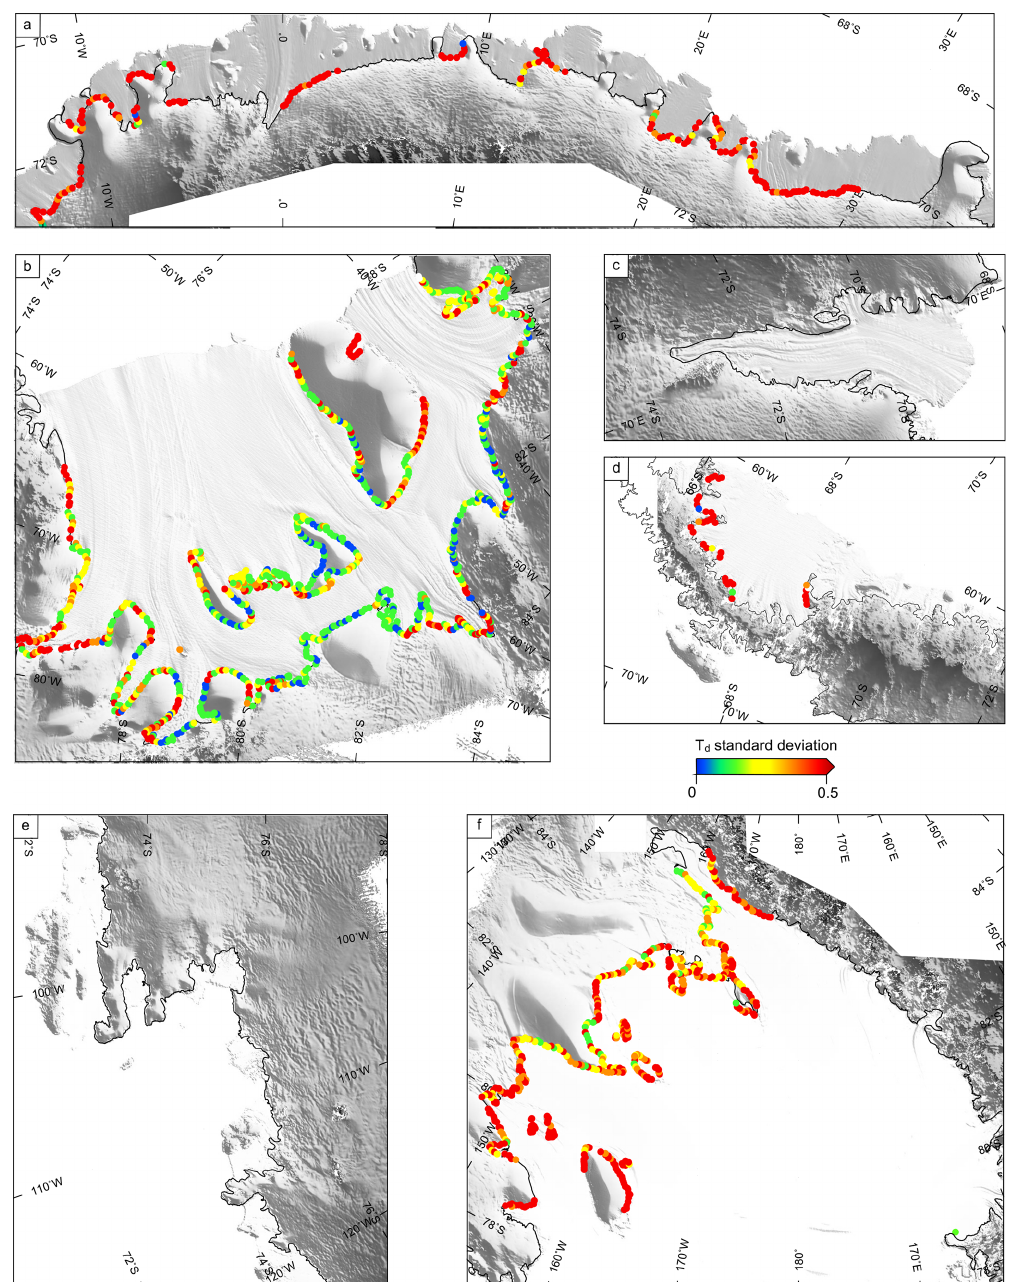
Figure A4. The standard deviation of T d for the mapped grounding zone for (a) Dronning Maud Land, (b) Filchner–Ronne Ice Shelf, (c) Amery Ice Shelf and (d) Antarctic Peninsula. (e) Amundsen Sea sector and (f) Ross Ice